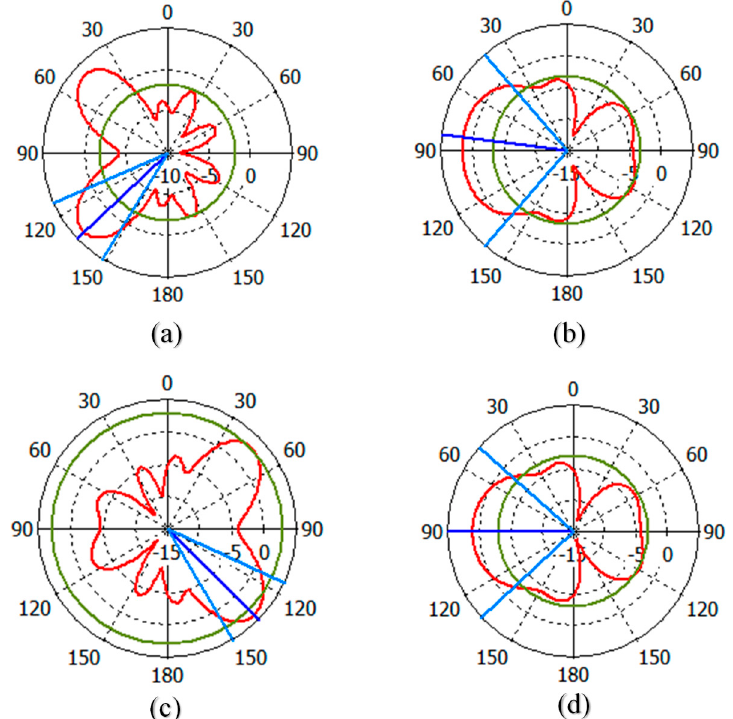
Figure 8. The radiation pattern of the proposed antennas ( a ): E plane of antenna A ( b ), H plane of antenna A ( c ), E plane of antenna B ( d ), and H plane of antenna B ( b ).